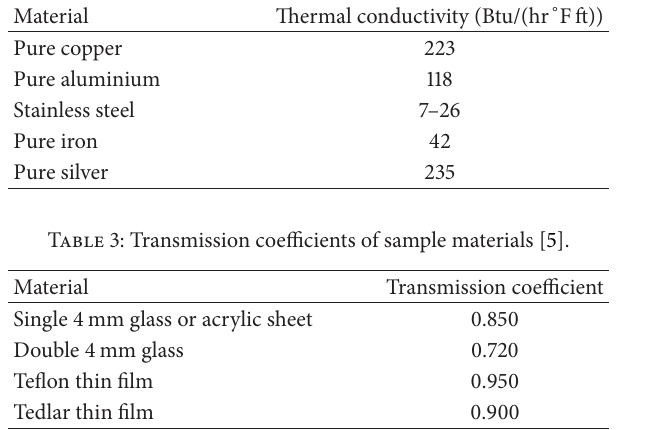
Average insolation for all the towns is 4.775kWh/m 2 .